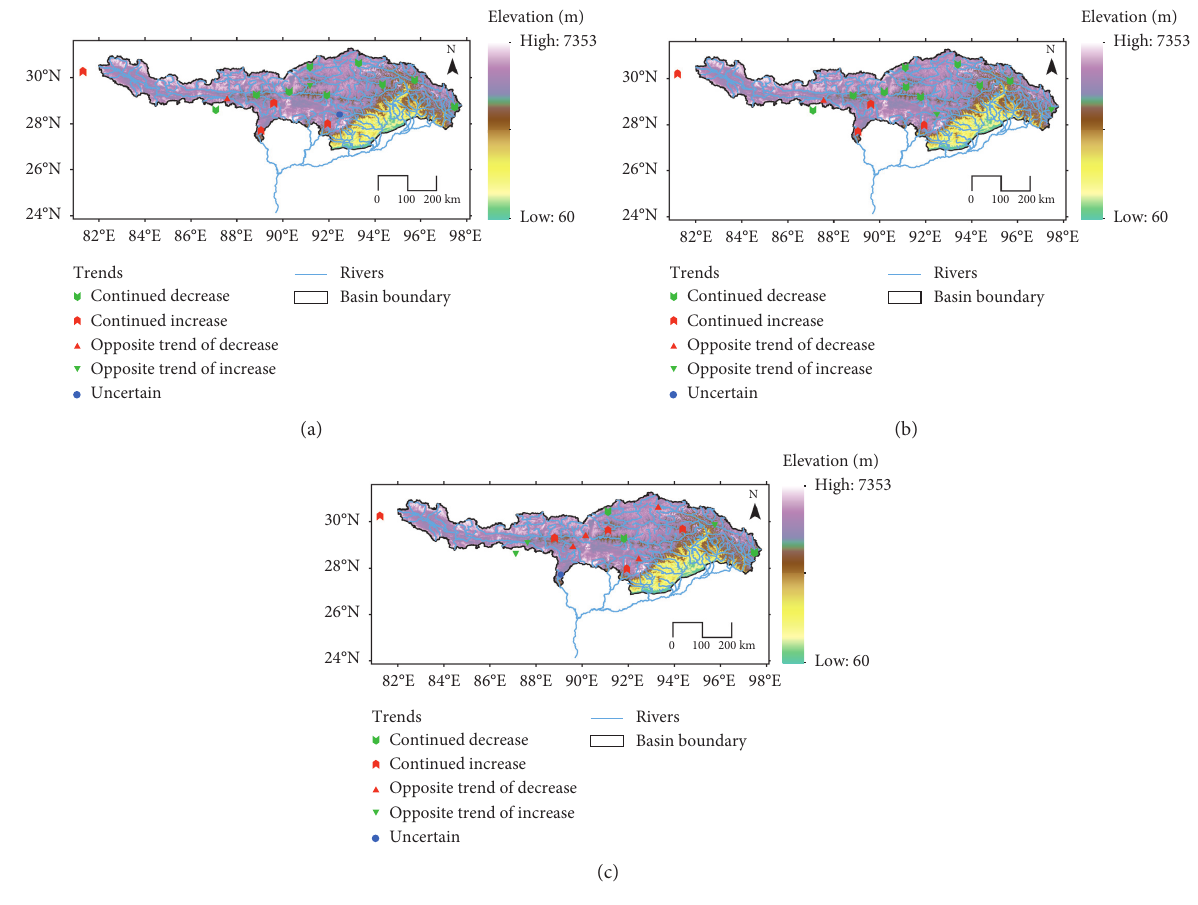
Figure 7: Spatial distribution of future CI. (a) Year. (b) Wet season. (c) Dry